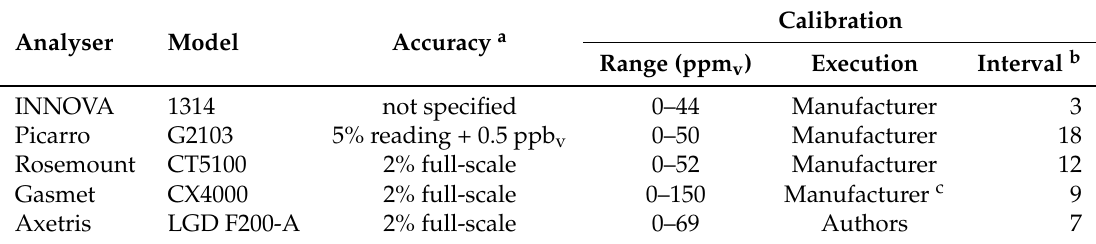
Table 1. Summary of the specifications of gas analysers for measuring ammonia (NH 3